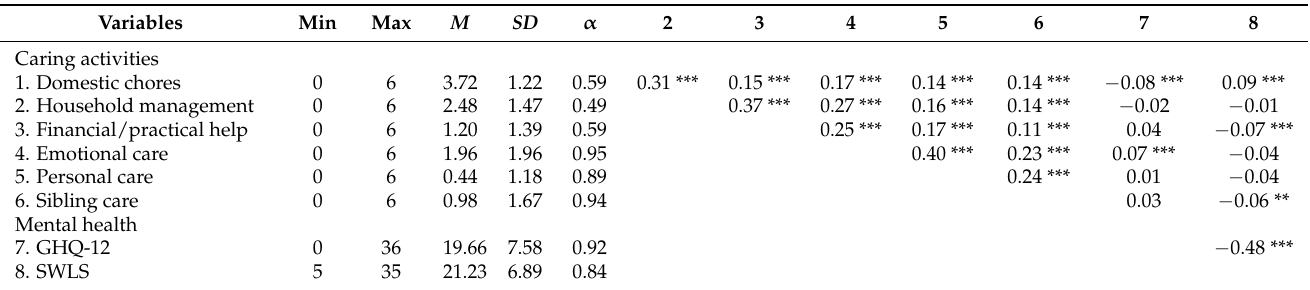
Table 2. Descriptive statistics, internal consistencies, and correlations between caring activity domains and mental